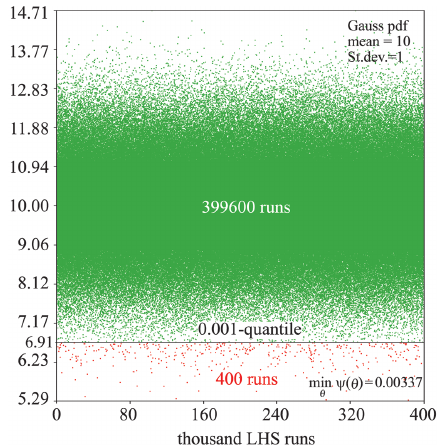
Figure 1. Example of the estimate of the 0.001-quantile from 400 000 LHS runs 101×104 mm (300×300